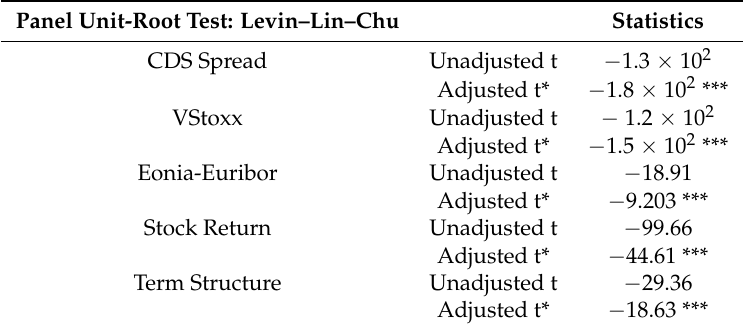
Table A2. Panel unit-root test: Levin–Lin–Chu. T-statistics are reported; *** stands for statistical significance at 1%.